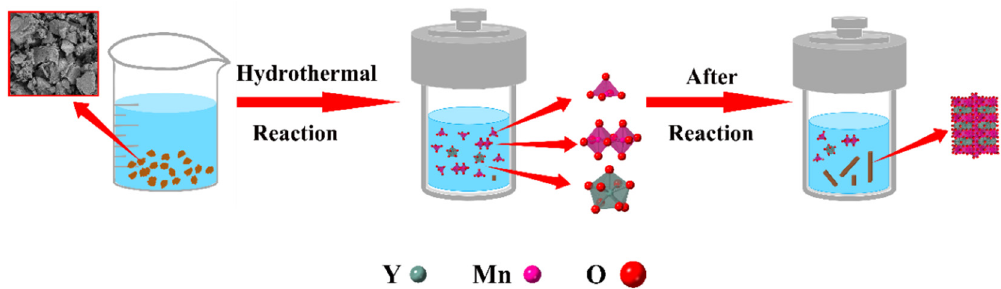
Figure 9. Schematic model of dissolution and recrystallization for YMn 2 O 5 .